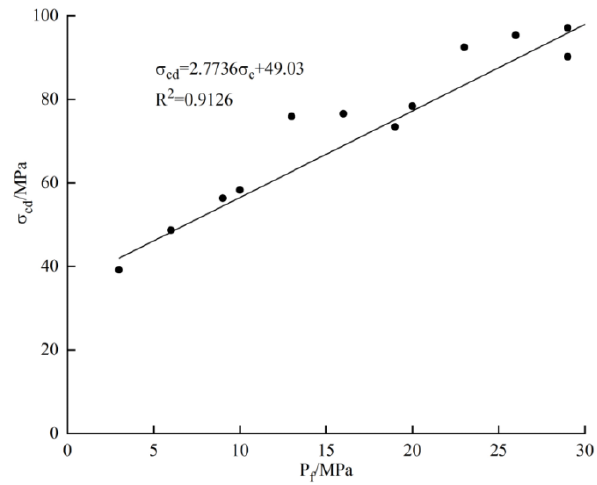
Figure 6. Relationship between the dilatancy stress and effective confining pressure.